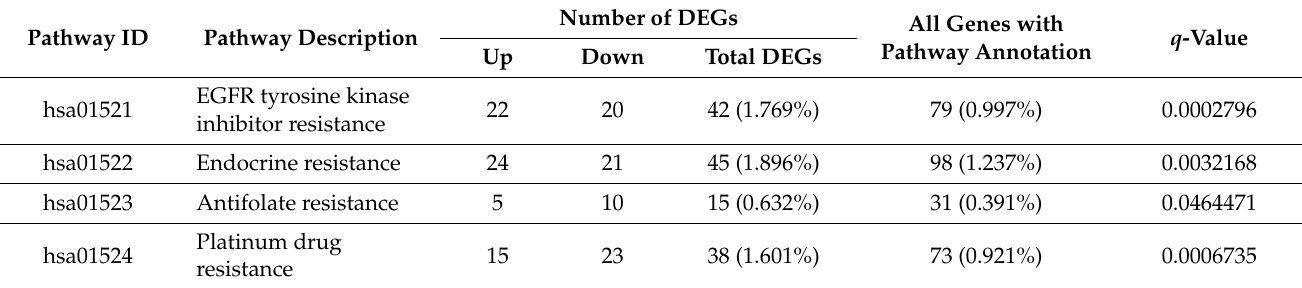
Table 3. Drug resistance pathway analysis of chlorophyllides